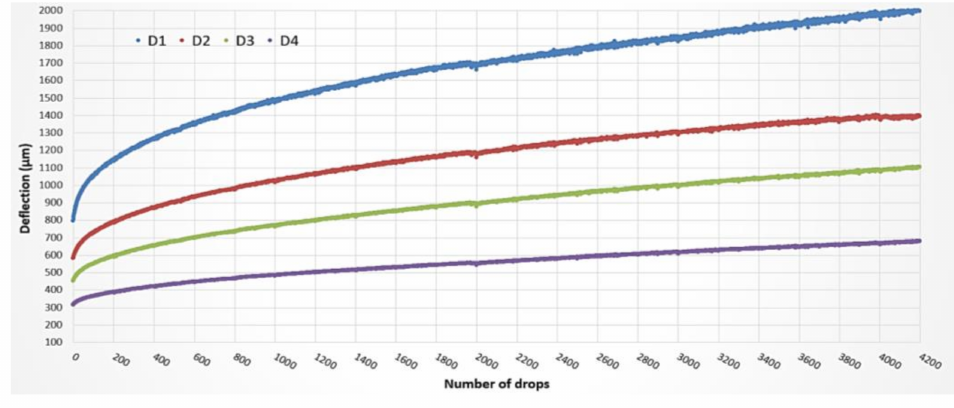
Figure 7. Example of recorded deflections for the test point